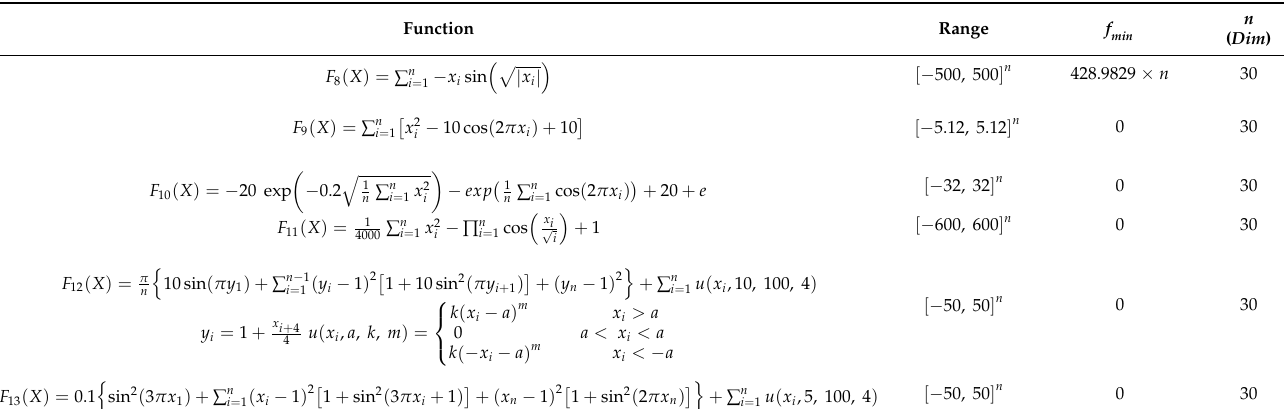
Table 4. Multimodal benchmark